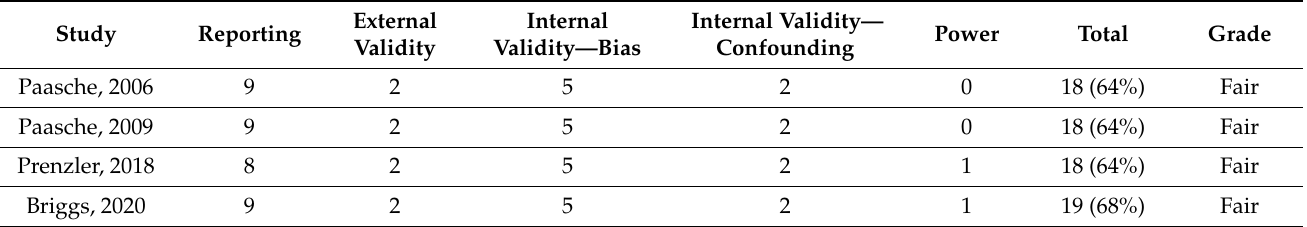
Table 3. Checklist for the assessment of the methodological quality of human studies.